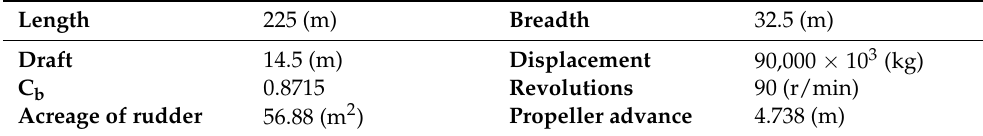
Table 2. Principal parameters of the ship.